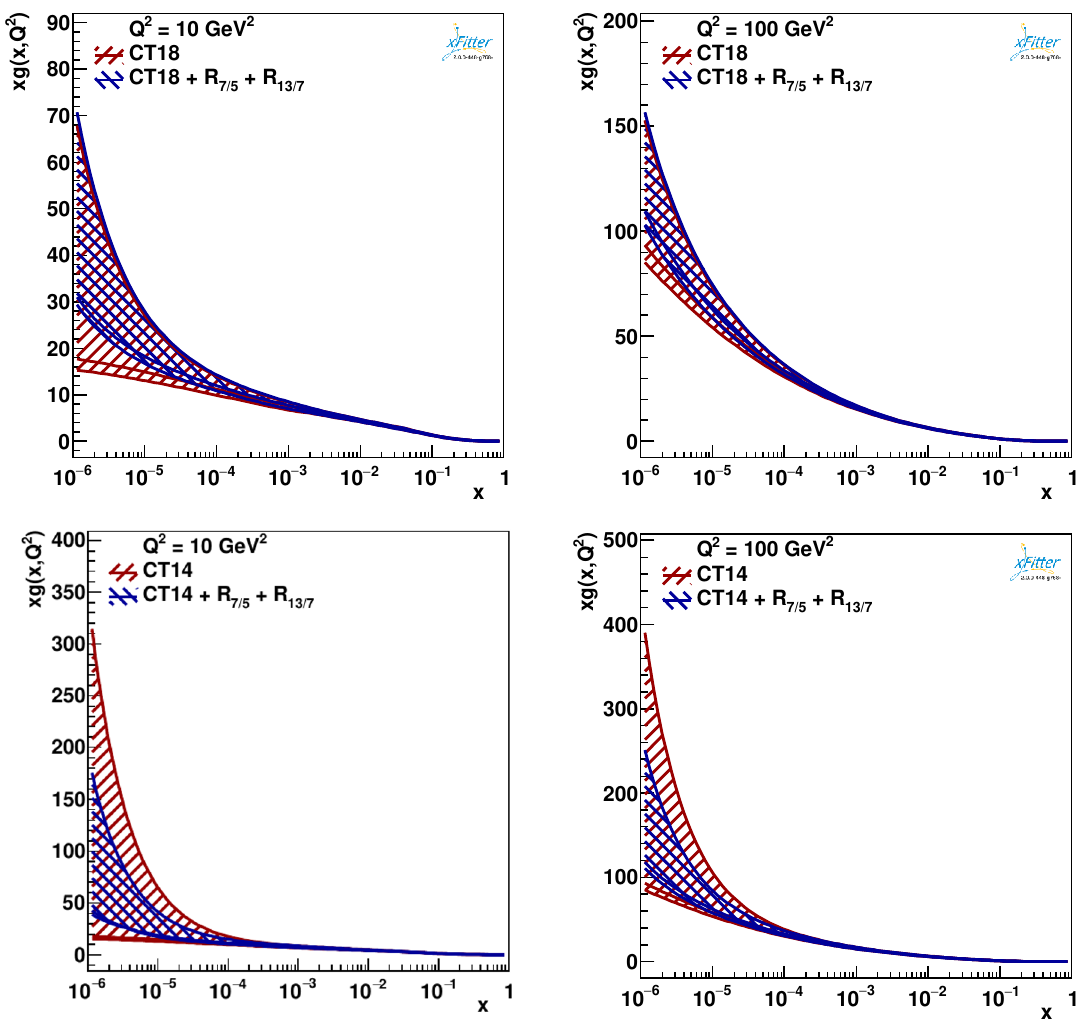
Figure 21 . Same as figure 20, but for the CT18 PDF at Q 2 = 10 GeV 2 (up left) and Q 2 = 100 GeV 2 (up right) and for the CT14 PDF at Q 2 = 10 GeV 2 (down left) and Q 2 = 100 GeV 2 (down right), all at